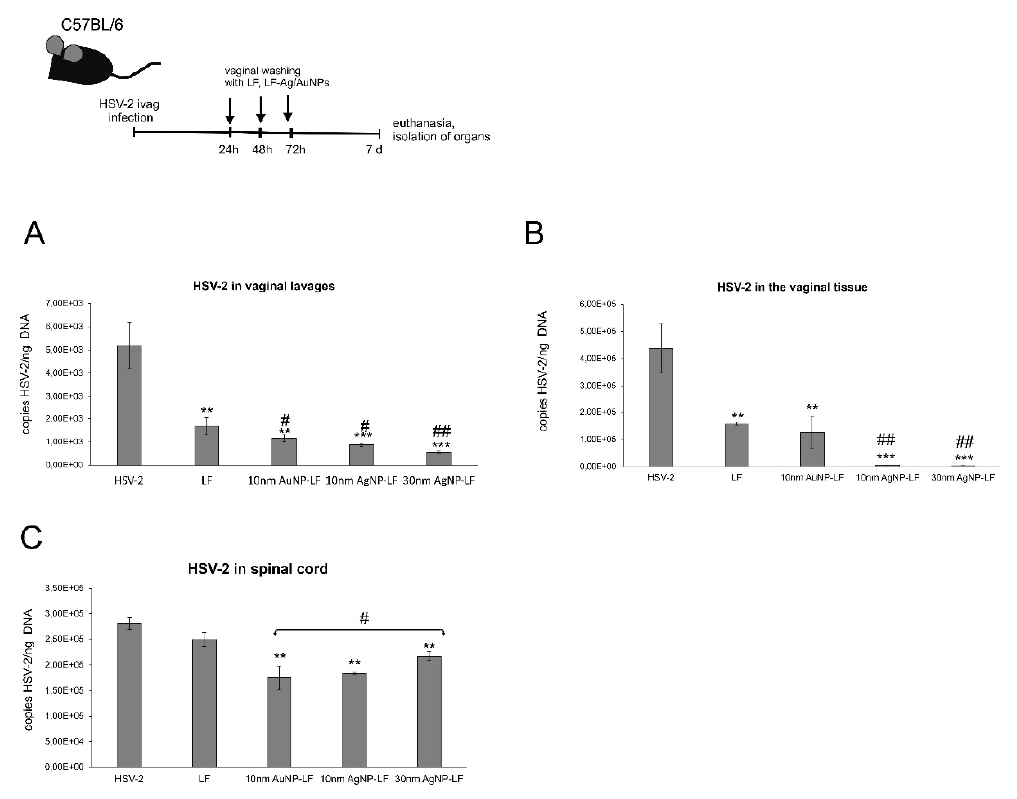
Figure 5. Treatment with lactoferrin-modified Ag/AuNPs reduce HSV-2 infection in vivo. C57BL/6 Figure mice infected with HSV-2 were treated three times every 24h with 10 nm LF-Ag/AuNPs, 30 nm LF- AgNPs or lactoferrin (1 µg/mouse). ( A ) Vaginal lavages collected at 72 h p.i. ( B ) Vaginal tissues and ( C ) spinal cords isolated at 7 d p.i. were subjected to measurement of HSV-2 gB titers (copies/ng DNA) by qPCR ( N = 10). The bars represent means ± SEM. * represents significant differences with ** p ≤ 0.01 and *** p ≤ 0.001 in comparison to untreated HSV-2 tissues. # represents significant differ- ences with p ≤ 0.05, ## p ≤ 0.01 in comparison to lactoferrin treated HSV-2 infected tissues (Mann– Whitney U test).